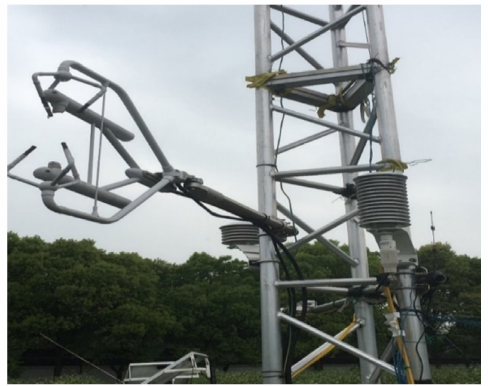
Figure 2. The eddy covariance system placed on a pole in the study area at the height of 2.3 m.